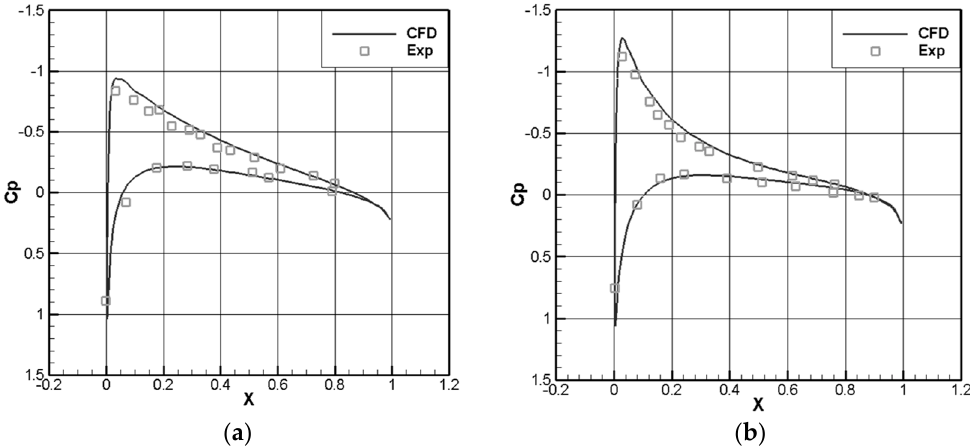
Figure 3. Pressure coefficients along the rotor section: ( a ) r = 0.68, ( b ) r = 0.96.